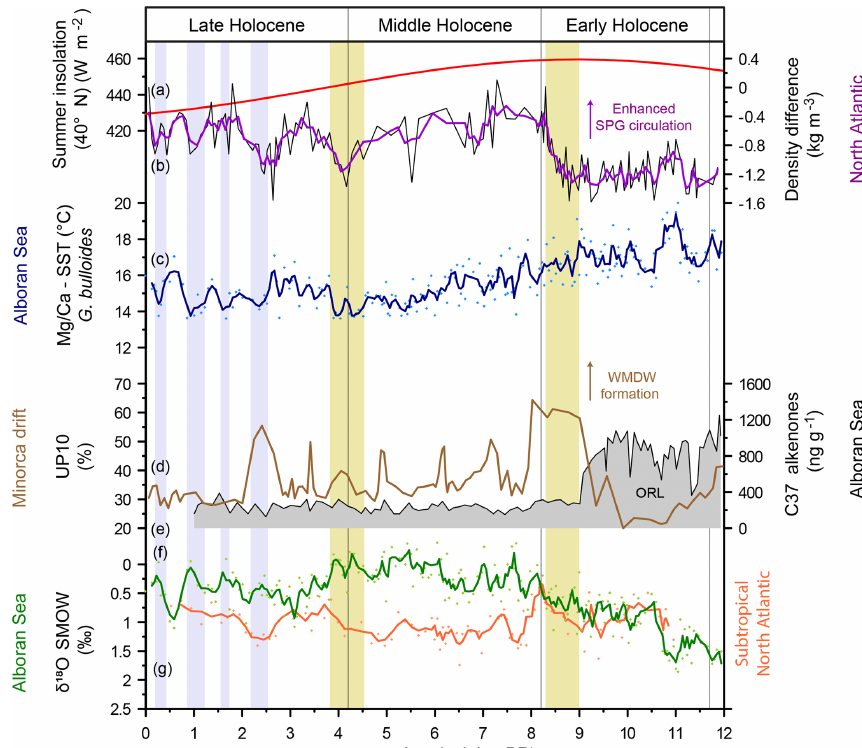
Figure 5. Holocene evolution for the Alboran Sea surface hydrography related to oceanographic processes in the North Atlantic. (a) In red, the summer insolation at 40 ◦ N. (b) In purple, the three-point average of density differences (kgm − 3 ) between G. bulloides and G. inflate from the North Atlantic record RAPiD-12-1K (Thornalley et al., 2009). (c) The new Mg / Ca SST ( ◦ C) presented in this work from the ALB-2 (Alboran Sea) – light-blue dots correspond to each SST result and the bold dark-blue line corresponds to the three-point average. (d) In brown, the UP10 fraction (%) from the Minorca drift core MD99-2343 (Frigola et al., 2007). (e) The grey filled line represents the concentration of C 37 alkenones in the Alboran Sea record MD95-2043 (Cacho et al., 2002). (f) In green, the new δ 18 O sw ‰ (SMOW) presented in this work from the ALB-2 (Alboran Sea). (g) In orange, the calculated δ 18 O sw ‰ (SMOW) from the south Azores record GEOFAR-KF16 (Repschläger et al., 2017). Centred vertical bars: 8.4–9cal.kyrBP corresponds to the Alboran Sea and North Atlantic synchrony in oceanographic changes; 4.2cal.kyrBP corresponds to the double peach structure observed for ALB-2 Mg / Ca SST. The four vertical grey bars during the Late Holocene correspond to cold events of the ALB-2 Mg / Ca